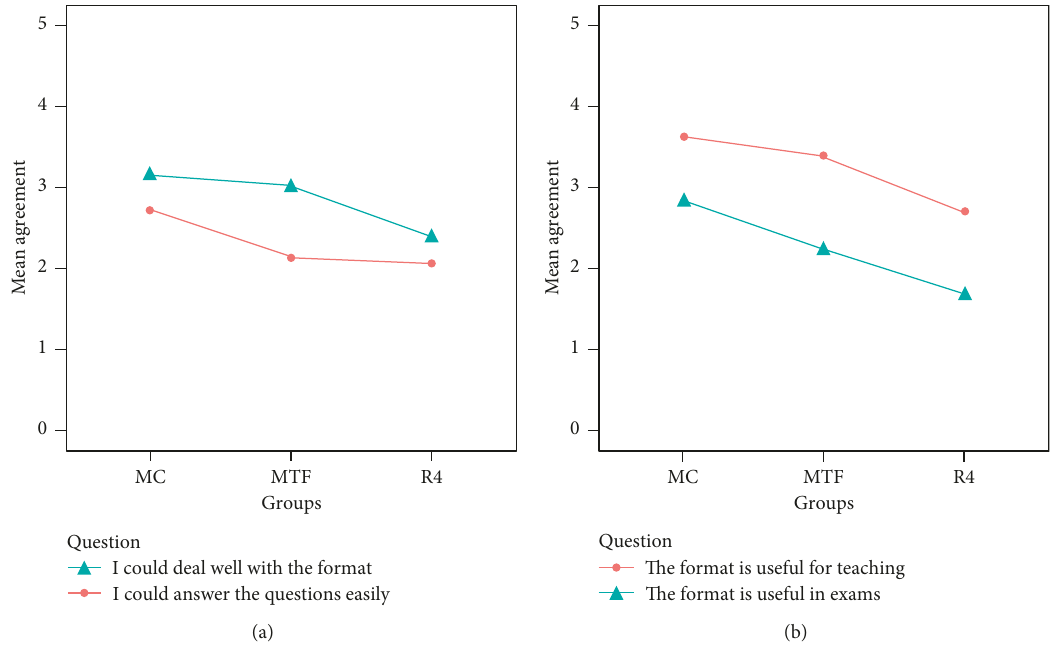
Figure 6: Year 2013 evaluation. Mean agreement in the three groups to the statements shown at the bottom of the panels.